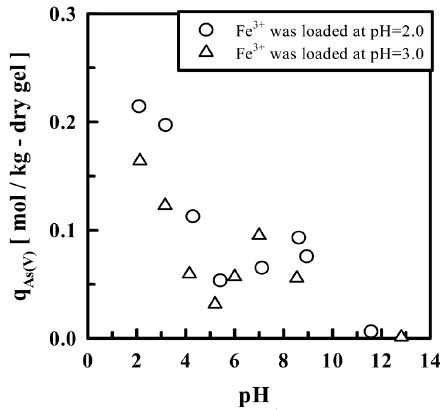
Figure 11. Amount of As(V) adsorbed (q As(V) ) by crosslinked pectic acid gel loaded with Fe(III) plotted against the equilibrium pH [12]. (With permission for reuse from The Society of Chemical Engineers, Japan).